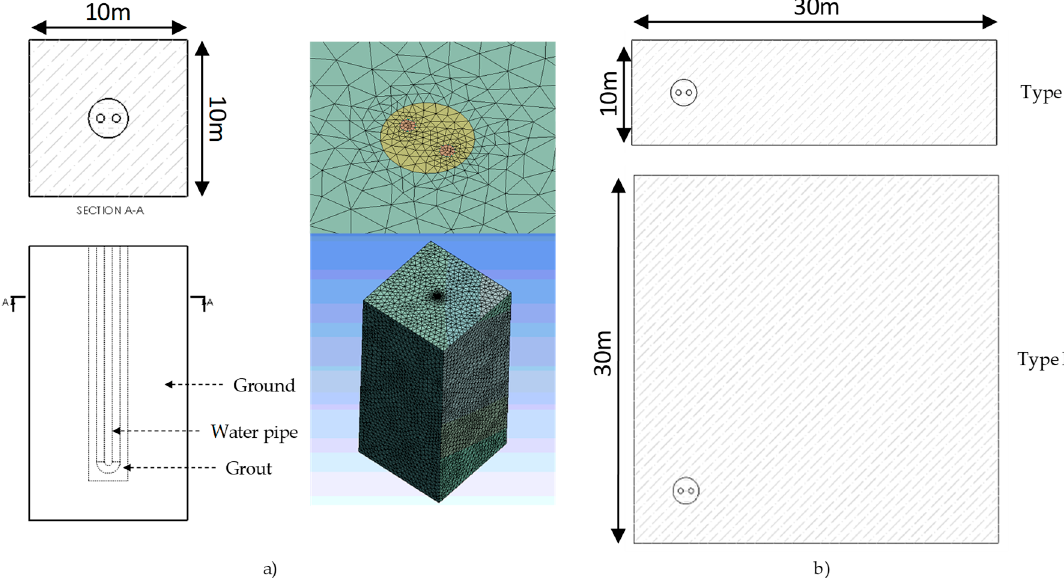
Figure 2. ( a ) Geometry (out of scale) and mesh for borehole Type I model; ( b ) geometry for boreholes Type II and III .